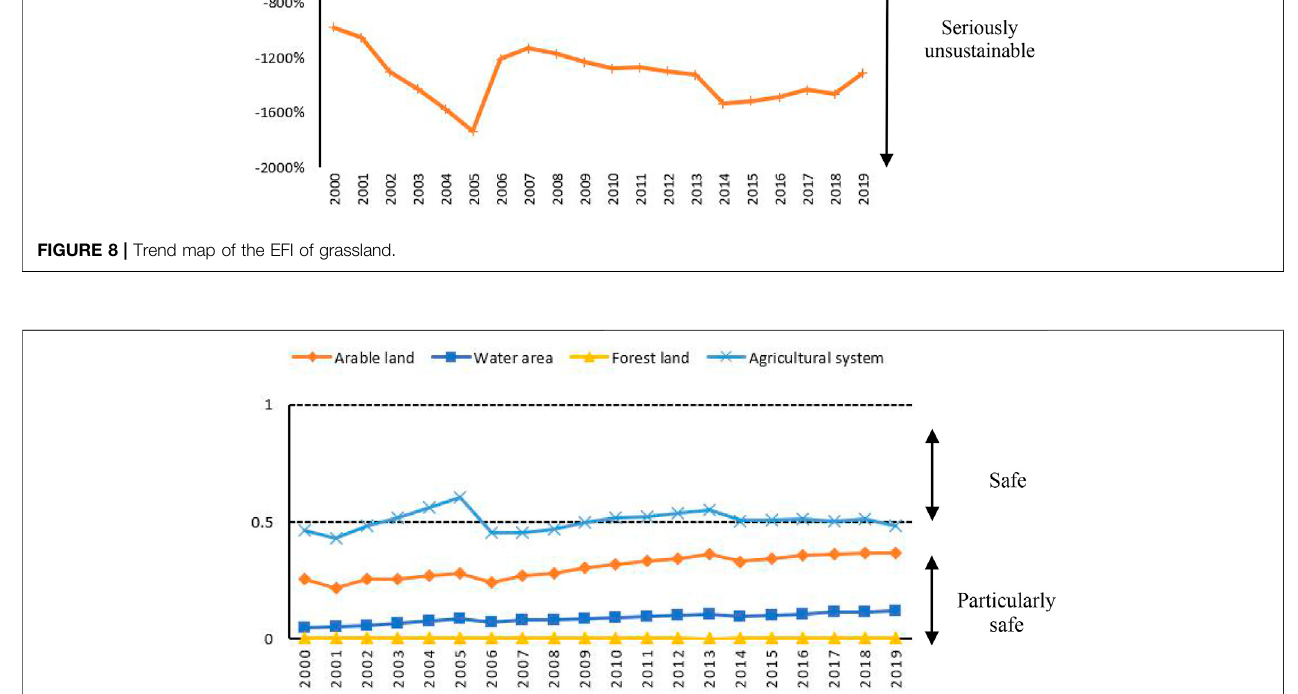
FIGURE 9 | Trend map of EPI of cultivated land, water area, and forest land (EPI = 2).